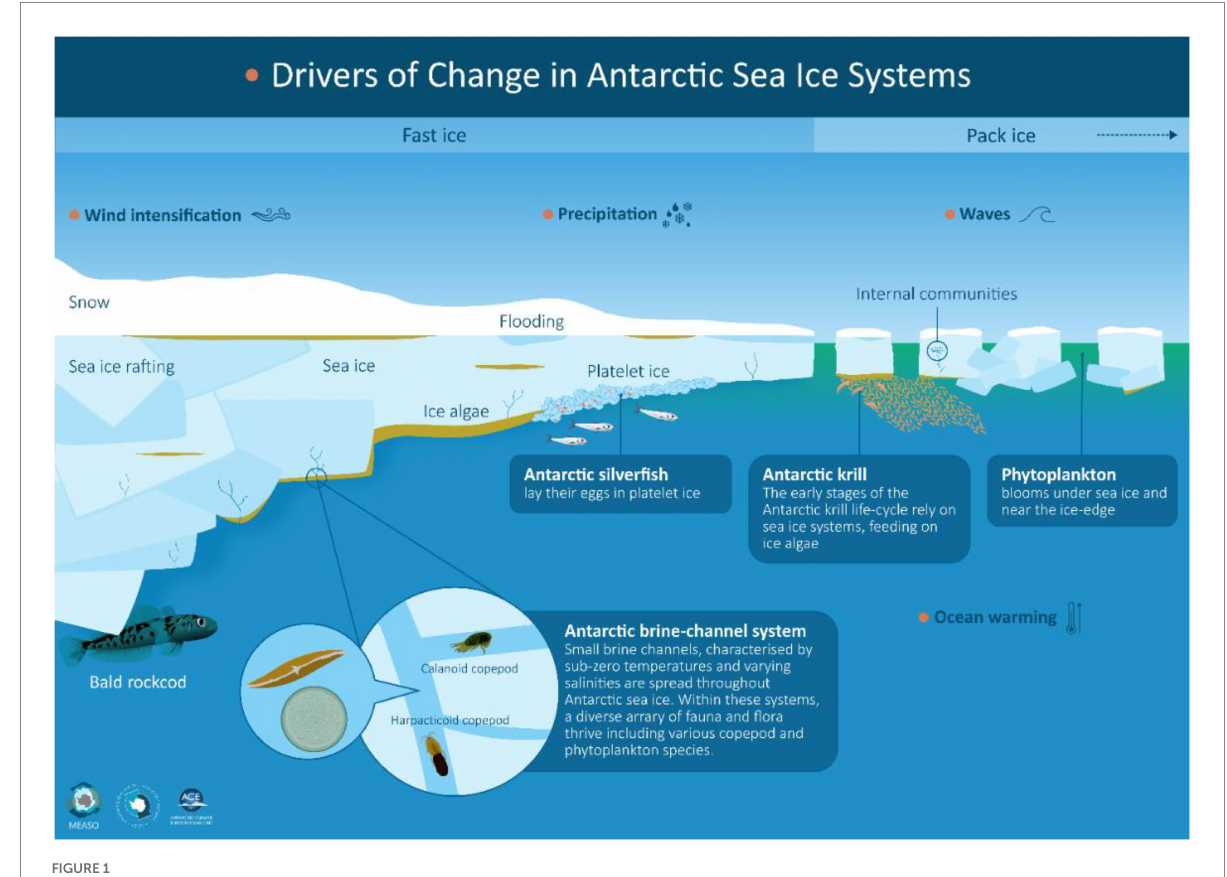
FIGURE 1 Sea ice habitat showing transition from inshore (stationary) landfast ice to offshore (mobile) pack ice. The diagram features key ice-associated biota and the drivers of change that are used as perturbations in the qualitative network analysis (see Table